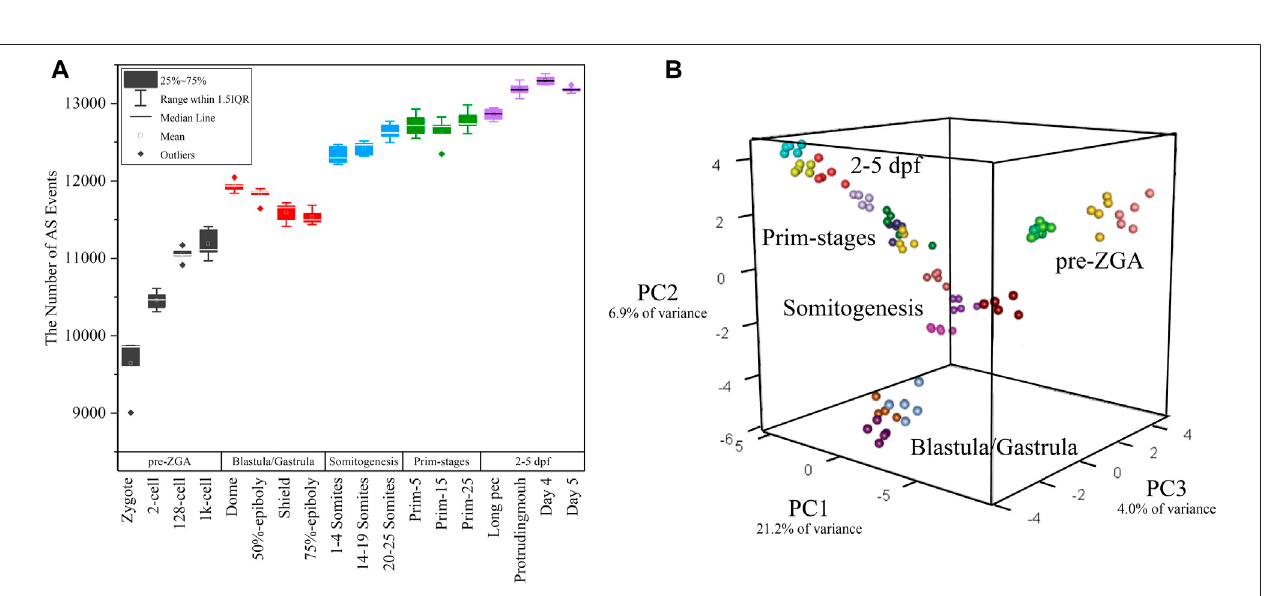
Frontiers in Cell and Developmental Biology |